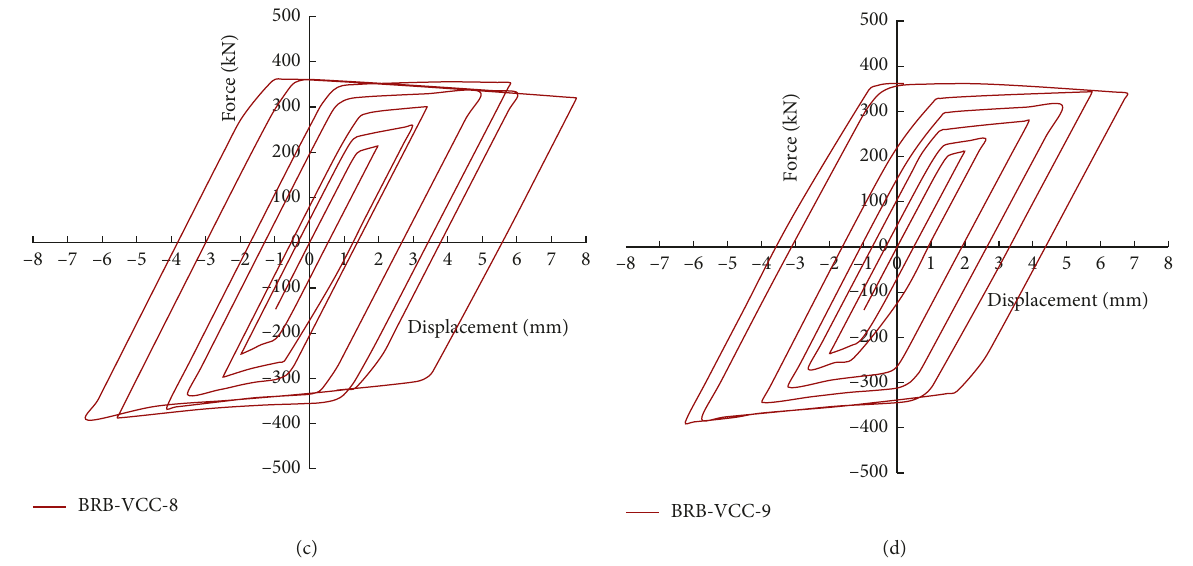
Figure 21: Hysteresis curves of models. (a) BRB-TJ-I. (b) BRB-VCC-7. (c) BRB-VCC-8. (d) BRB-VCC-9. Table 6: Comparisons of FEM analysis results.